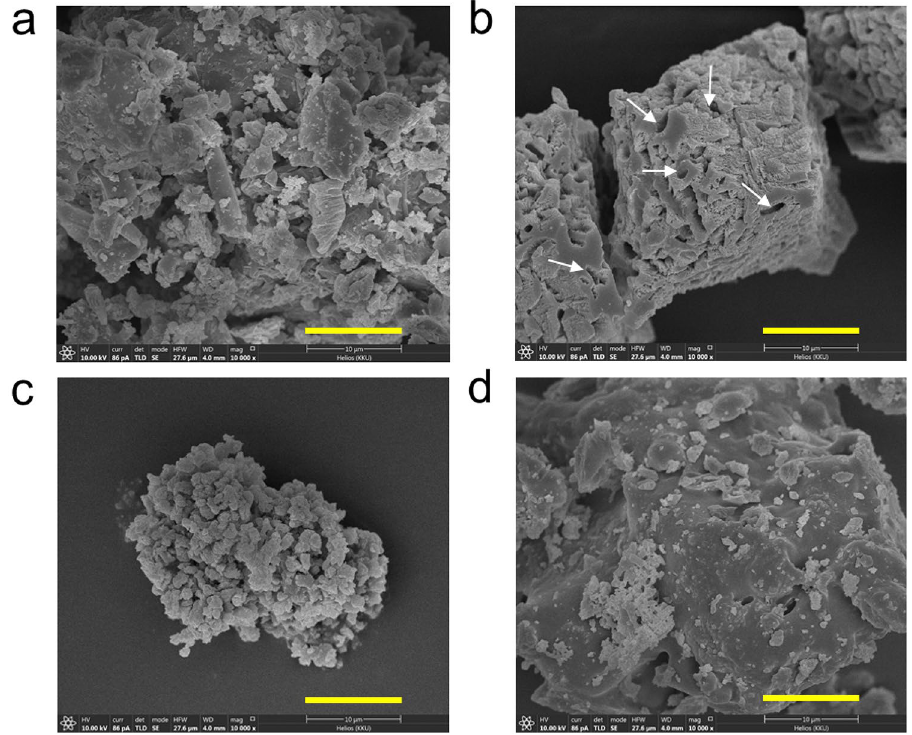
Figure 1. SEM micrographs (10,000X magnification) of raw materials used for producing cementitious composites; ( a ): OPC powder, ( b ): biogenic CaCO 3 produced by Lysinibacillus sp. strain WH, ( c ): IWFC powder and ( d ): IBFC powder. White arrows indicate bacterial cell